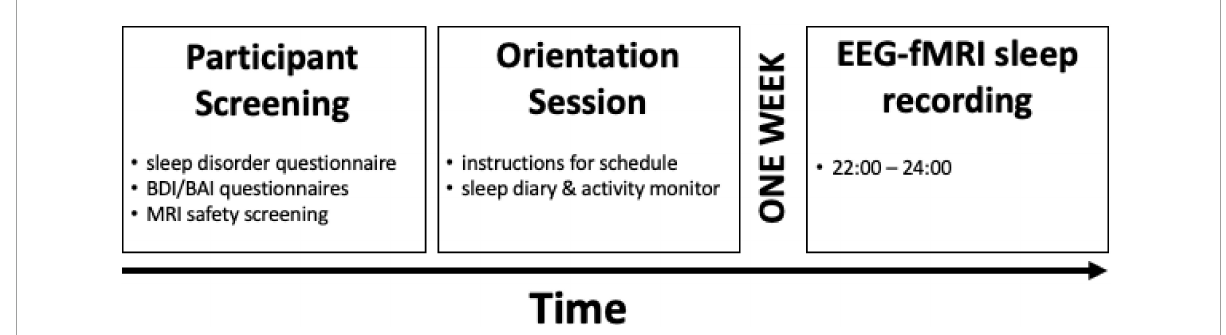
FIGURE1 Study design. Participants underwent an initial screening to rule out any signs of sleep disorders, unusual sleep habits, or other health-related criteria and MRI compatibility. Eligible participants then visited the sleep laboratory for the orientation session at least 1 week before the EEG-fMRI sleep recording night, in which participants were given detailed instructions about the study procedure, the sleep diary, and an activity monitor. Finally, participants completed the EEG-fMRI sleep recording session beginning at 9 P.M, with lights out for the sleep session at 10 P.M. The sleep session ended at 12 A.M. Reproduced with permission from cerebral